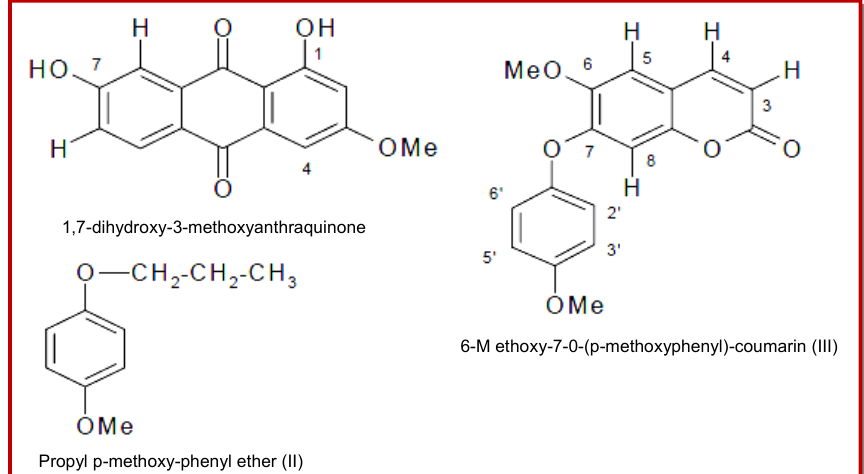
Figure 1: isolated from the ethyl acetate extract of the strain AL-2 by silica gel column chromatography and